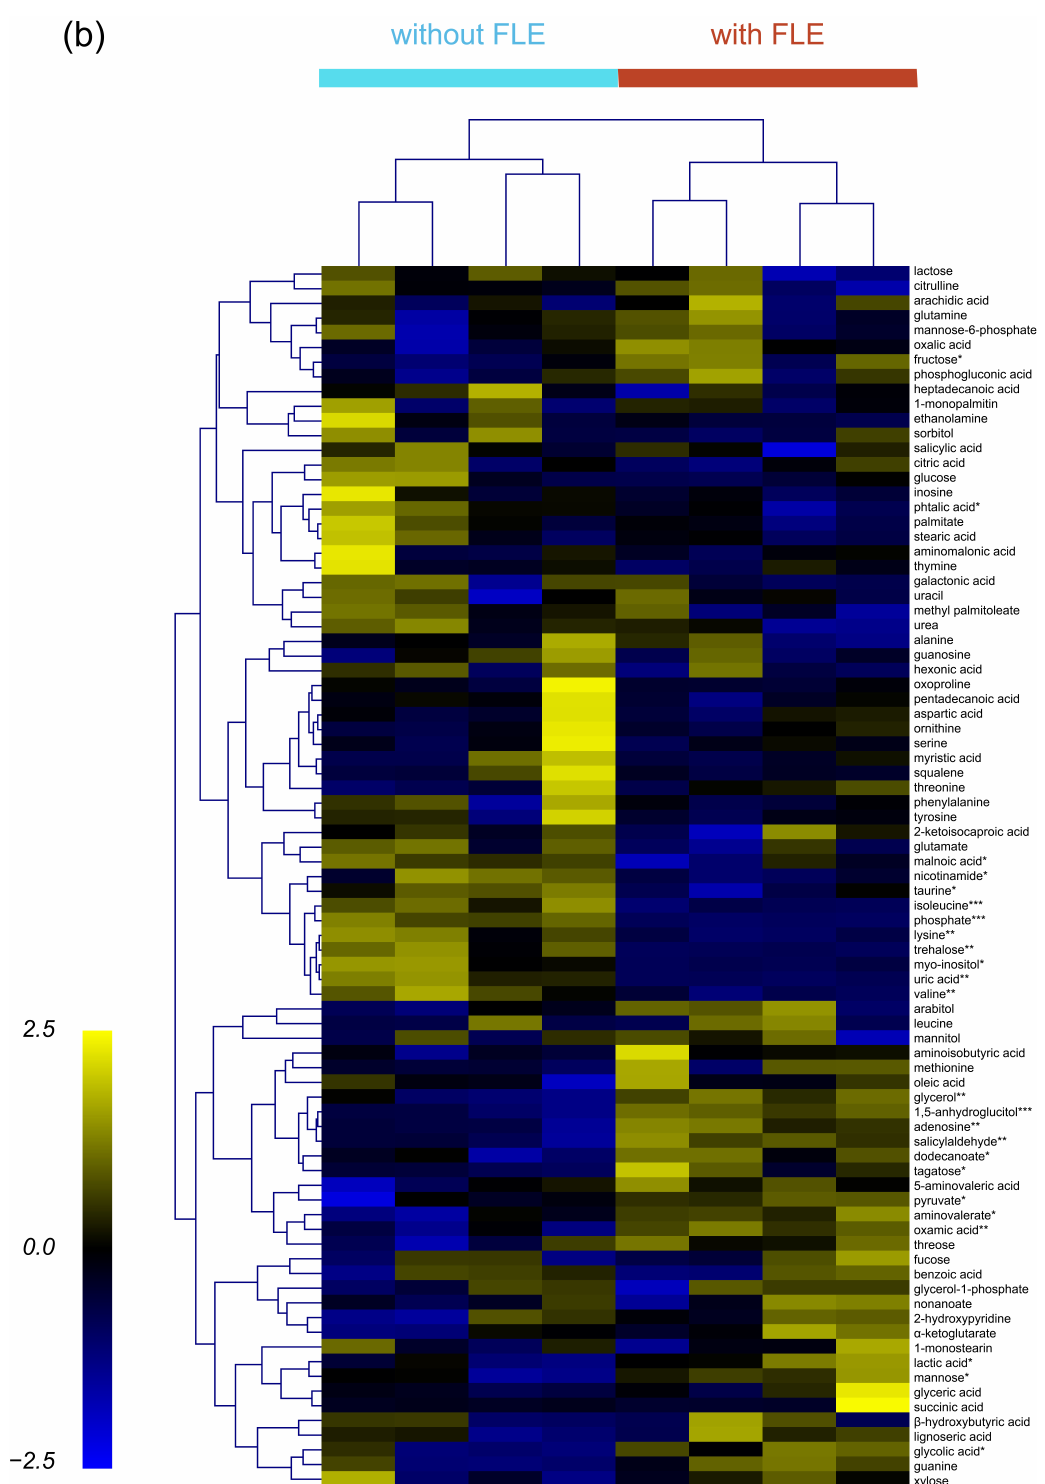
Figure 3. ( a ) Score plot of the principal component analysis (PCA) and ( b ) heatmap of hierarchical clustering analysis for the serum metabolite profiles of mice feed standard (without fermented lettuce extract (FLE)) and noodles with FLE. Significant differences were set as * p < 0.05, ** p < 0.01, and *** p < 0.001.